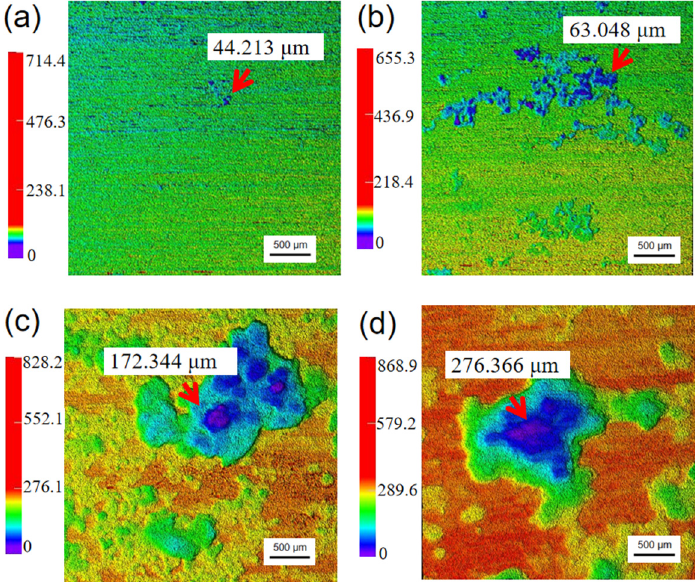
Figure 9. Laser confocal scanning microscopy (LCSM) of AZ31 magnesium alloy specimens without corrosion products exposed for different periods in marine environment of ocean voyage. ( a ) 1 month, ( b ) 3 months, ( c ) 6 months, ( d ) 12 months.